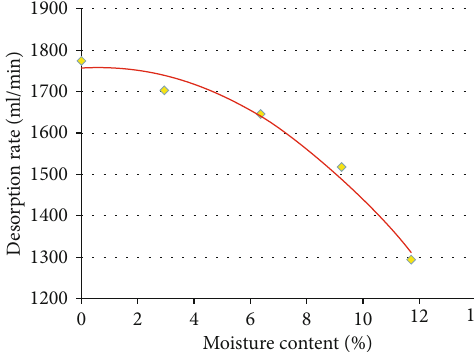
Figure 6: Initial gas desorption speed of the coal bodies under di ff erent water content conditions.